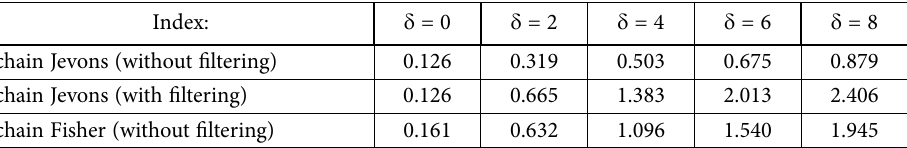
Table 2. Mean absolute distances between considered chain indices and the target GEKS price index (p.p): Case 2 Index: d =